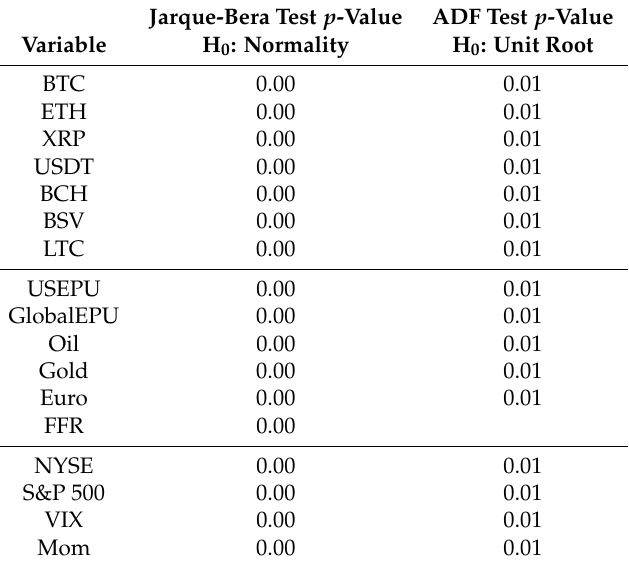
Table 4. Normality test and unit root